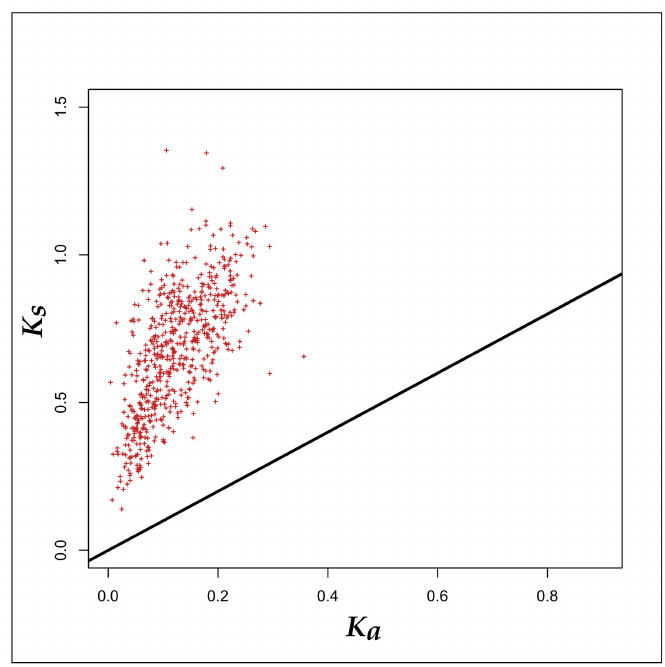
Figure 3. A plot of K a versus K s of the 613 gene groups of the orthologous genes from the 56 PHBifs. Straight line represents K a = K s . Each symbol (+) represents a gene group of 56 orthologous nucleotide sequences from the 56 bifidobacterial genomes. The figure implies that the rates of synonymous substitutions for 613 core genes is higher than that of the non-synonymous substitutions. The resulting core proteins will not be altered and remain conserved during